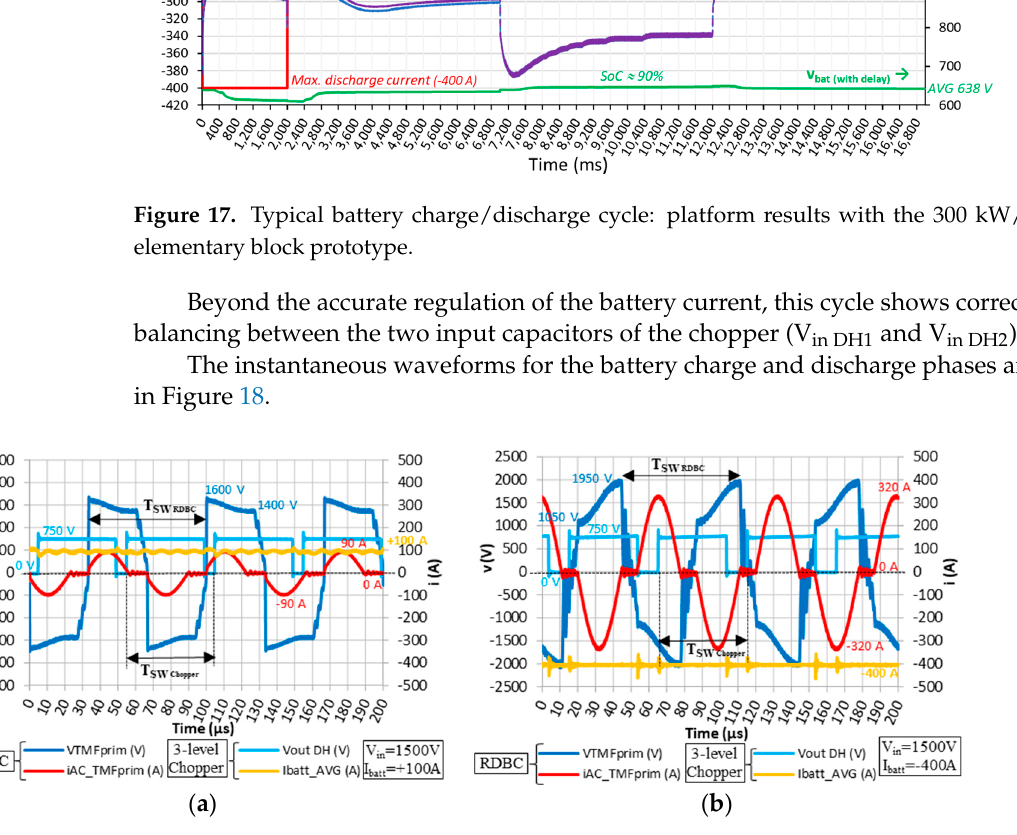
Figure 18. Elementary block of 300 kW/147 kWh. Instantaneous waveforms: ( a ) battery charging at maximum current (i ba tt = 100 A); ( b ) ba tt ery discharging at maximum current (i ba tt = 400 A).